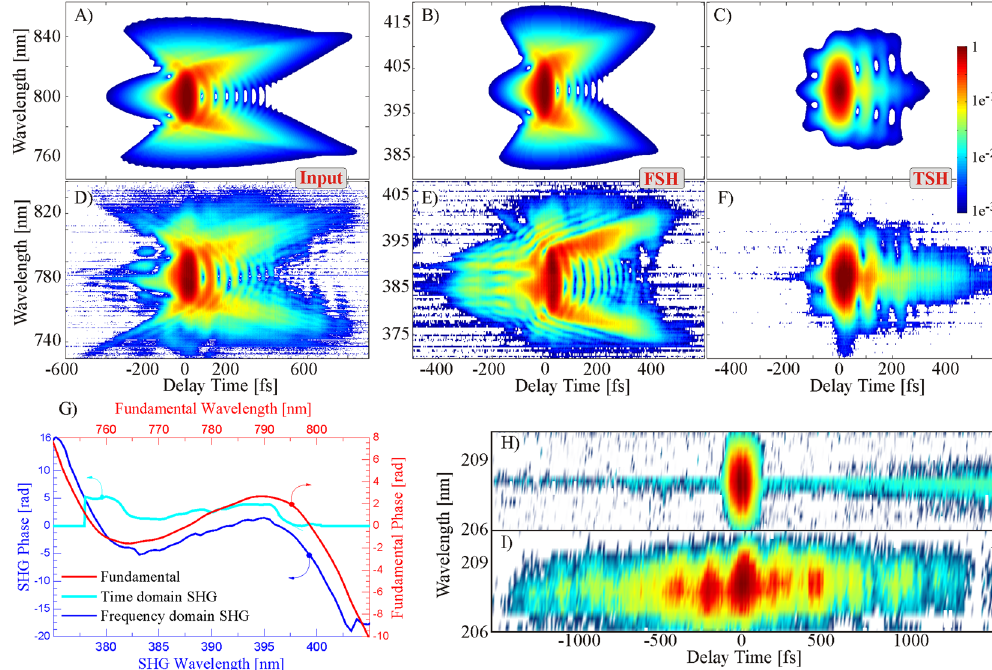
Figure 3. Theoretical ( A–C ) and experimental spectrograms at 800 nm ( D–F ) for FSH ( B,E ) and TSH ( C,F ) for pure phase shaping. In ( A ), a pure TOD of 150000 fs 3 was added to a 33 fs TL fundamental pulse. In the experiment ( D ), additional higher order distortion terms are present. In FSH ( B , E ), the butterfly shape is nicely preserved while it is completely washed out in TSH ( C , F ). The experimentally retrieved phases are given in ( G ). The blue line showing the phase obtained through FSH nicely follows the shape of the fundamental (red line). The SH phase stroke is larger by a factor of 2 as expected from Eq. 5. This is evident from the different ranges for the left and right phase axes which refer to the second harmonic and the fundamental, respectively. The cyan line corresponding to TSH, on the contrary, exhibits a completely different behaviour. Thus, arbitrary phase functions can only be transferred via FSH. Even deep-UV shaping is possible. A TL pulse at 207 nm is shown in ( H ) and a pulse train achieved by applying a sine-phase function to the 830 nm input pulses in ( I ). Incidentally, these are the first FROG trace ever taken at such low